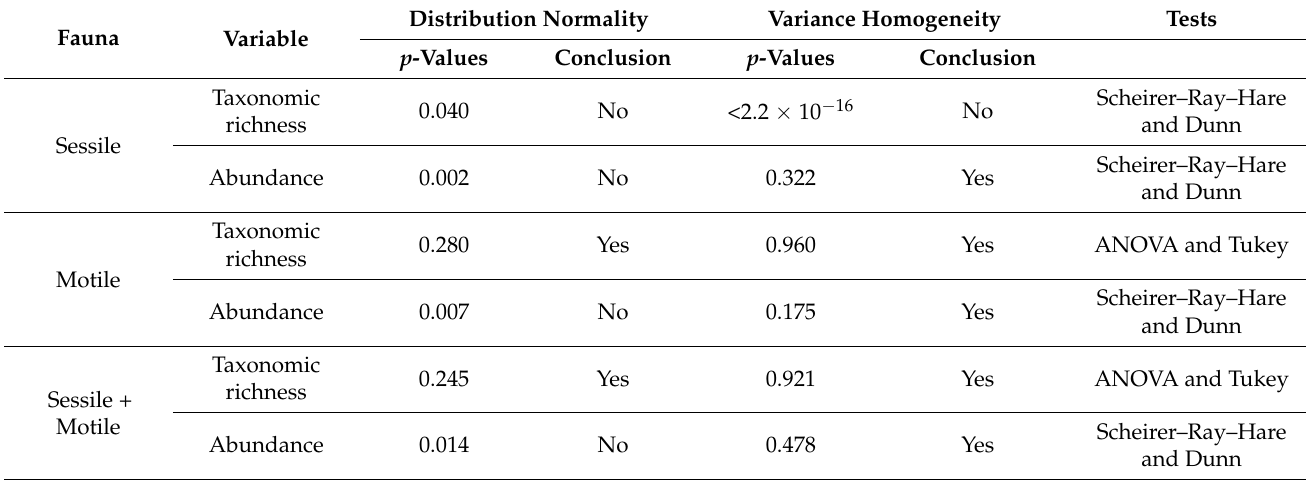
Table 1. Summary of the tests applied in each